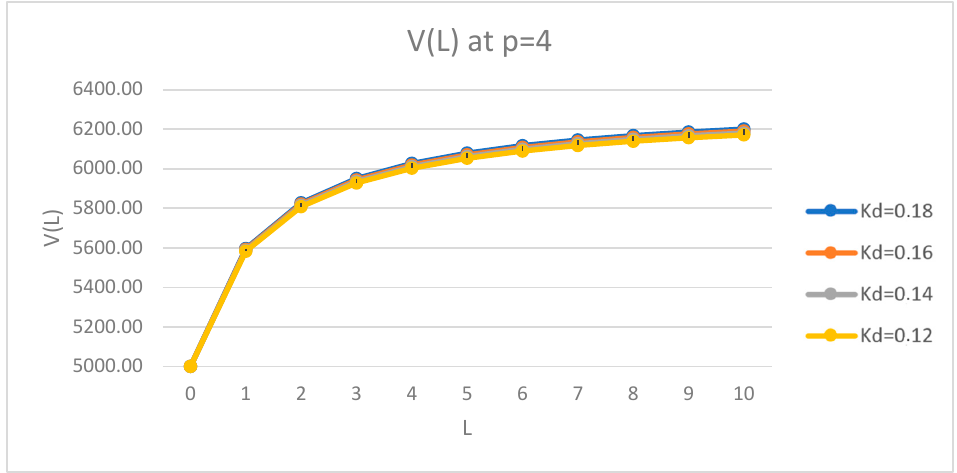
Figure 11. Dependence of the company capitalization, V, on leverage level L different debt cost k d (12%; 14%; 16%; 18%) and fixed frequency of payments of tax on profit p = 2 (larger scale).